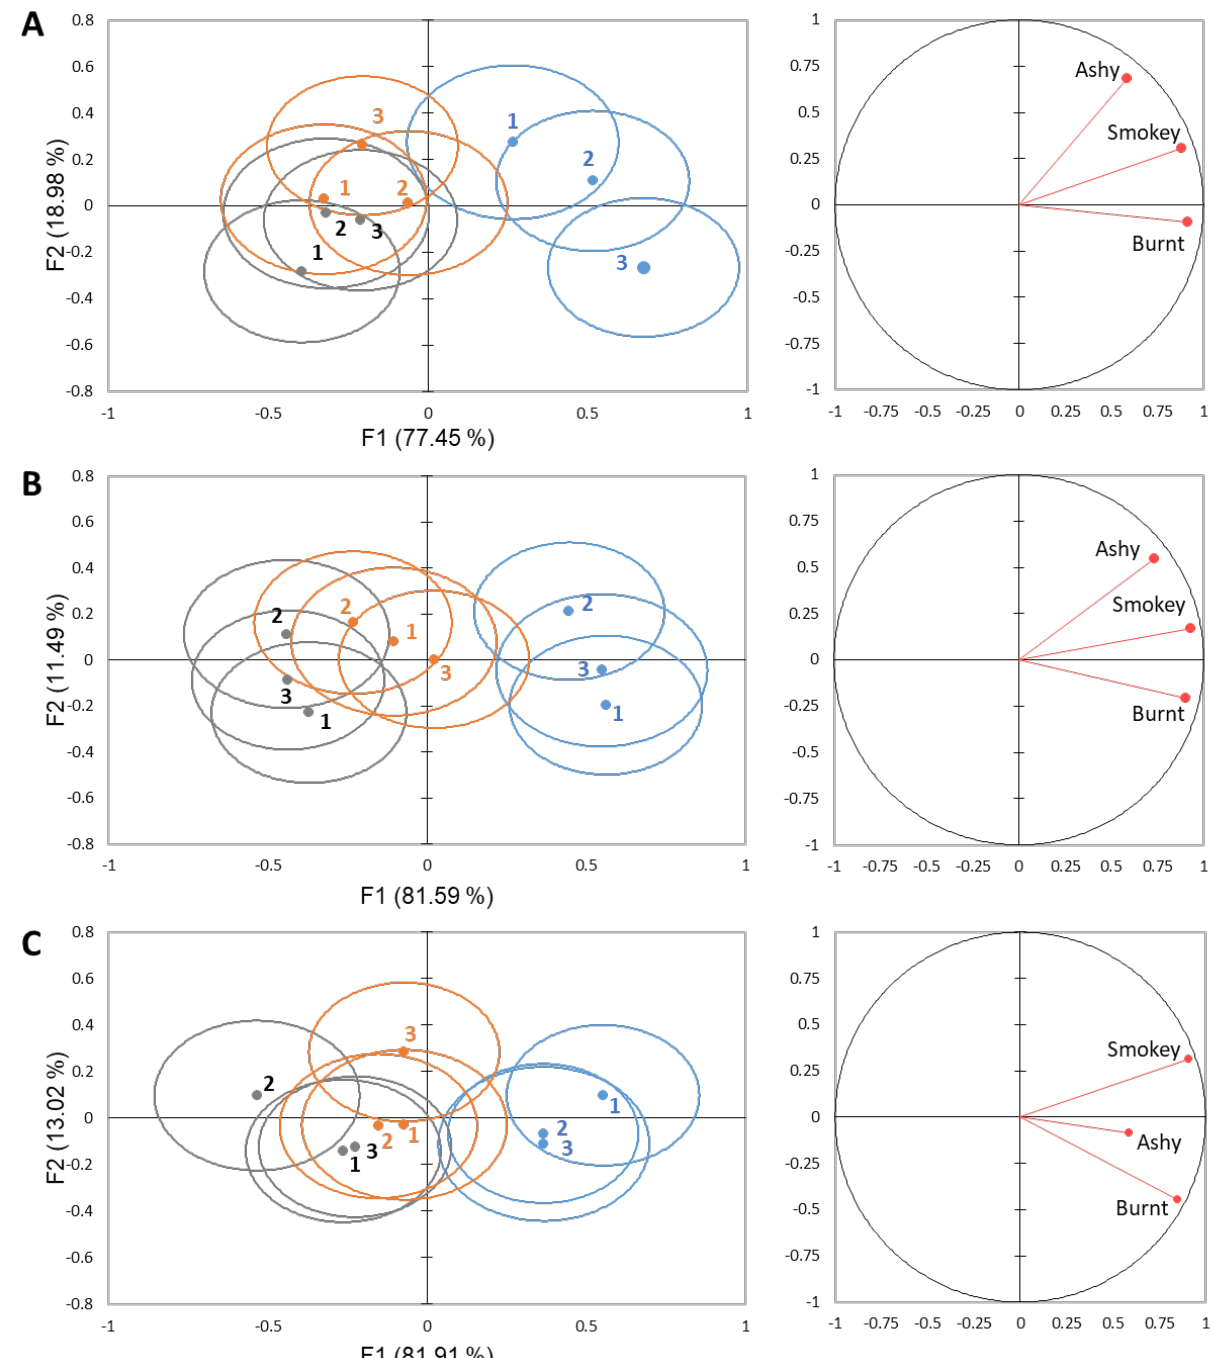
Figure 5. Separation of high smoke phenol (blue), moderate smoke phenol (orange), and low smoke phenol (grey) wines at each position within a set at 0 s based on DA from smoke-related attributes for each rinse system: ( A ) water, ( B ) pectin, and ( C ) mouthwash. Ellipses represent a 95% confidence interval, around the means.